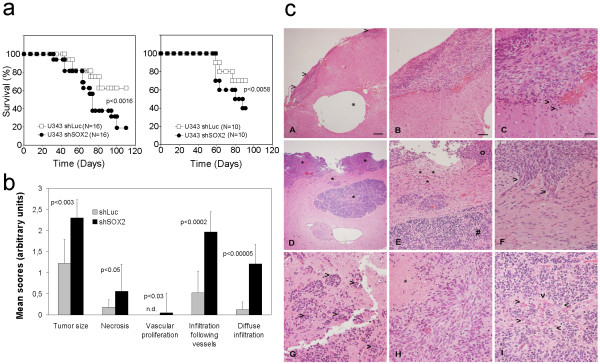
U343-MG xenografts with knockdown of SOX2 are tumorigenic and show a increased spreading in the mouse brain. a: Kaplan-Meier curves showing the survival of mice transplanted with 5 × 105 U343-MG cells with knock down of SOX2 and transduced with shLuc, respectively. Two independent experiments are depicted, which show a significantly reduced survival of mice transplanted with SOX2 depleted U343-MG cells. Number of animals for each experiment and p values for logRank-test are depicted. b: Semi-quantitative analysis of tumor size and specific traits of tumor spreading in the brain. Glioma cells with knockdown of SOX2 shows strong increased infiltration following vessels and diffuse infiltration into the normal brain parenchyma. Bars indicate standard deviation. The p values for student's t-Test are shown. c: Representative images of U343-MG gliomas in mouse brain. A-C: U343-MG tumors transduced with shLuc; D-I: U343-MG tumors transduced with shSOX #2378: A: Small superficially growing shLuc tumor (arrow heads) despite an intracerebral tumor cell reservoir (asterisk). B, C: Magnifications of the tumor area shows a compact growth pattern with clearly visible tumor borders and minimal single cell infiltration (arrowheads). D: U343-MG tumors with knockdown of SOX2 showing multilocular intracerebral growth (asterisks). E: Magnification of the tumor area showing two distinct tumor populations with spindle cell morphology and smaller rounded nuclei (#). Asterisks mark an area with intense single cell infiltration. F: Further magnification of the same area reveals tumor cells with spindle cell morphology growing along performed perivascular spaces (arrowheads). G: U343-MG cells with knock down of SOX2 growing at perivacsular spaces (arrowheads). H: Necrosis in U343-MG tumor with knockdown of SOX2 (asterisk). I: Area of U343-MG tumor with knockdown of SOX2 with small rounded nuclear morphology and glomeruloid vascular endothelium proliferation (arrowheads). Magnification bars for A and D: 160 μm; B and E: 80 μm; C, F, G, and I: 40 μm. n.d.: not detected.